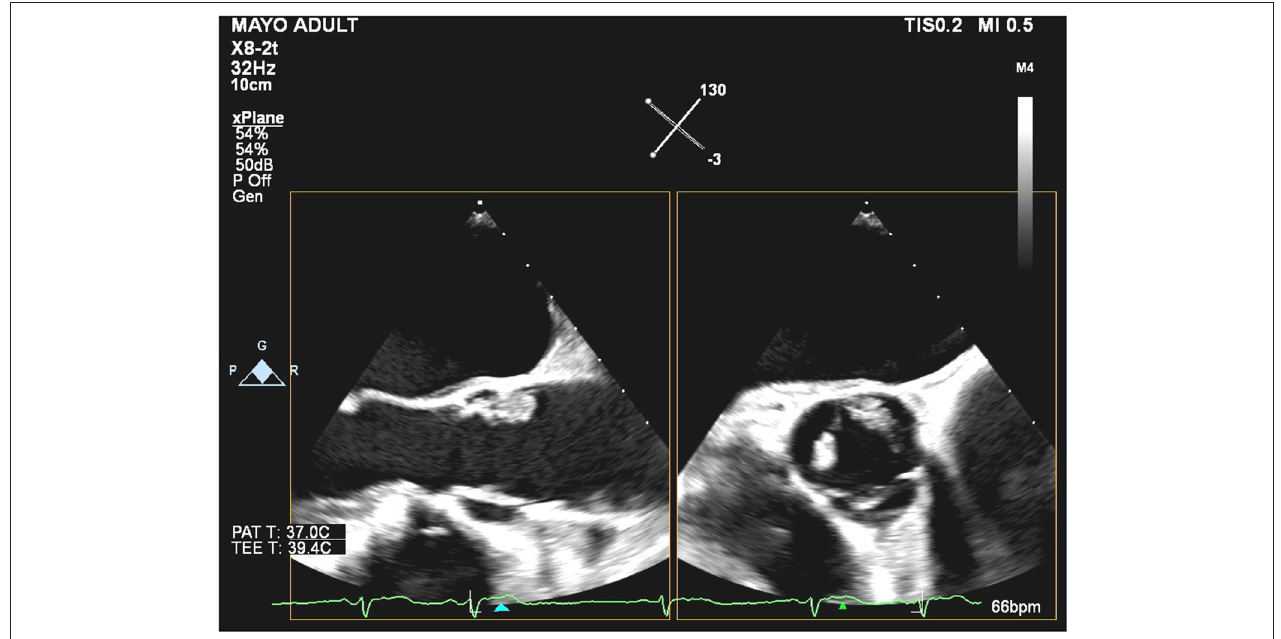
FIGURE 1 | Biplanar transesophageal echocardiography of the aortic valve during systole with the mid-esophageal aortic valve long axis (left) and short-axis